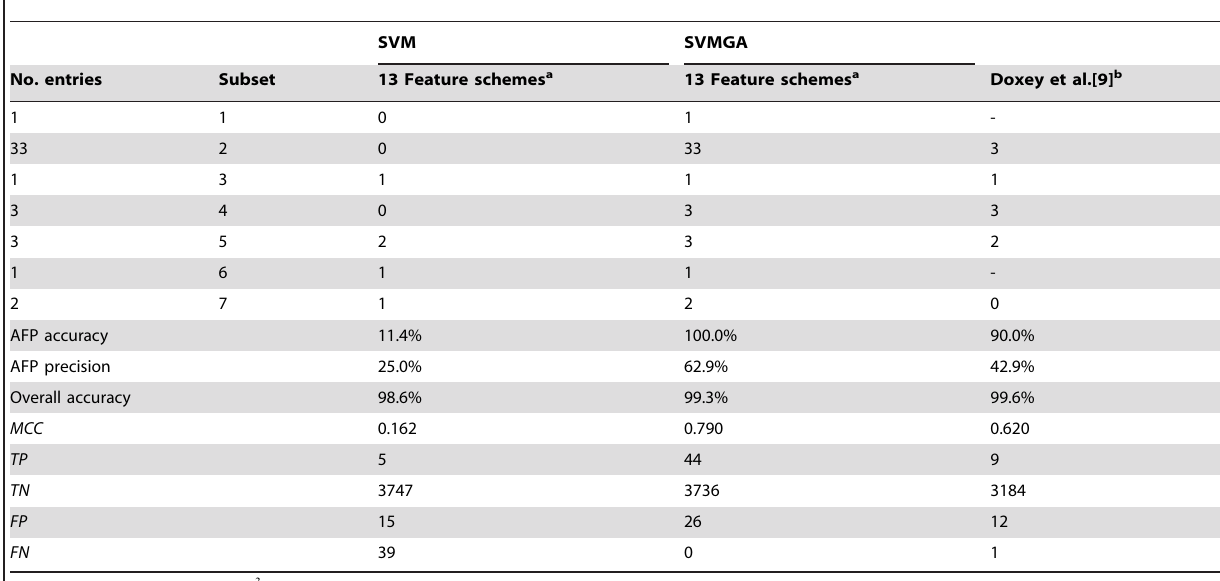
Table 3. Performances of SVM and SVMGA in the seven-fold cross-validation